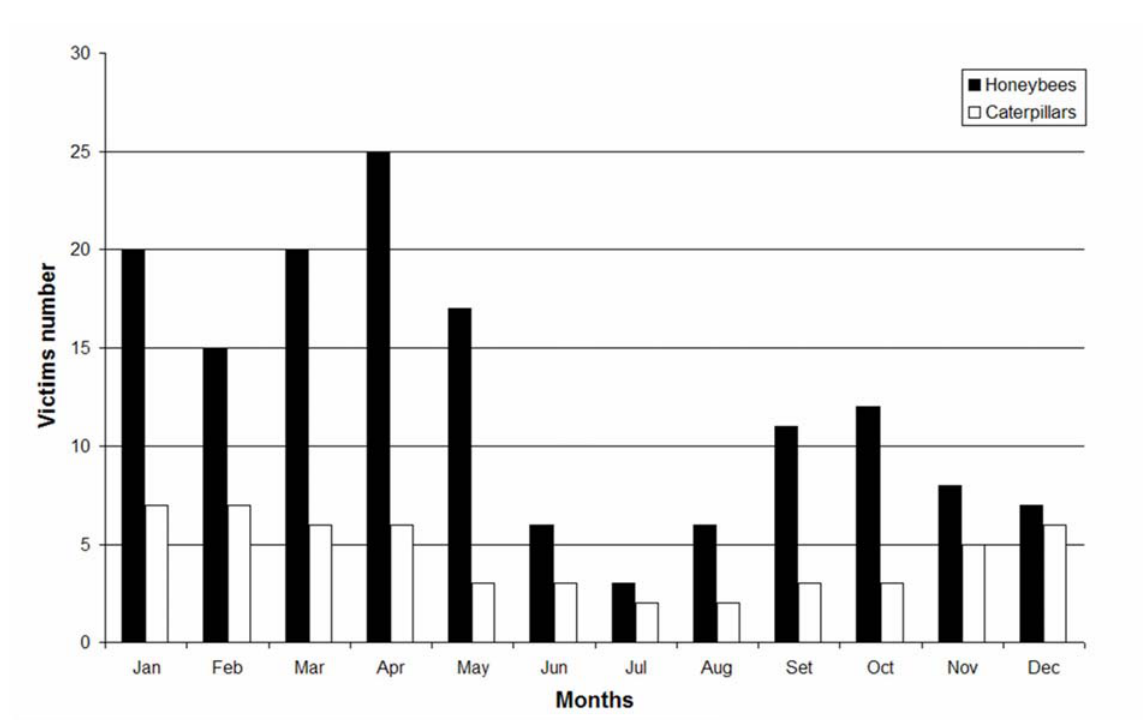
Figure 2. Frequency per month of stings by honeybees and caterpillars, recorded by the Municipal Health Secretary in the Criciúma region, Brazil, between 1994 and